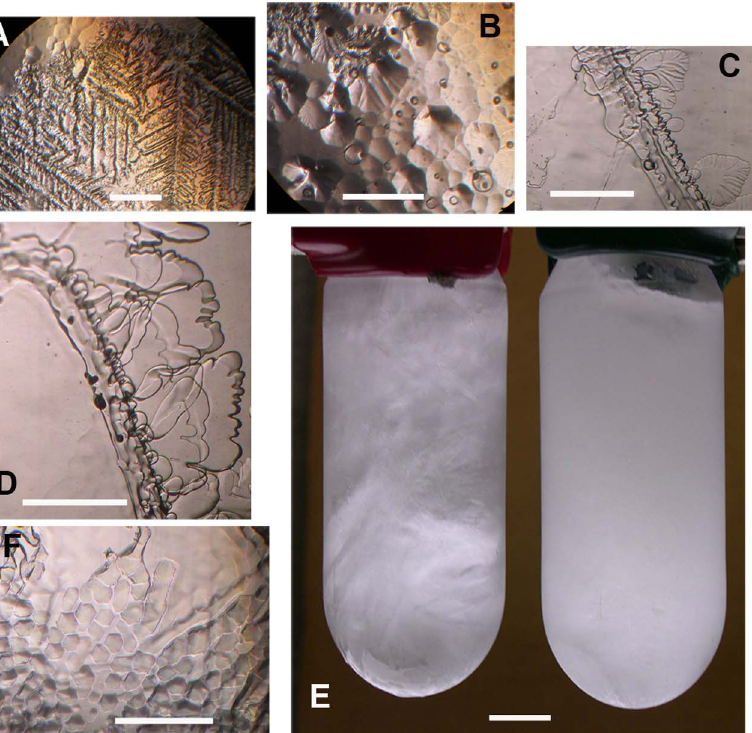
Figure 1. Effects of Chlamydomonasraudensis UWO241 ice-binding proteins on ice. A, Irregular ice dendrites growing from a prism face of ice in spent UWO241 medium. B, Pitted basal plane of ice grown in spent UWO241 medium. C, D, Featureless ice crystals (left) grown in the presence of unspent medium (C) and spent SAG49.72 medium (D). E, Effect of UWO241 IBP on the structure of saline ice. Unspent culture medium (700 mM NaCl with 1 6 Bold) (left) and cell-free spent culture medium containing a natural concentration of UWO241 IBP (right) frozen at 2 5.9 u C. The percentages of liquid and ice in the two tubes are the same (41% and 59%, respectively). Distortion of growing ice by the IBP greatly reduces the size of brine pockets. F, Basal plane of an ice crystal growing in an aqueous solution of recombinant UWO241 isoform 1 IBP. Scale bars, 1 mm, except in E where scale bar is 1 cm.